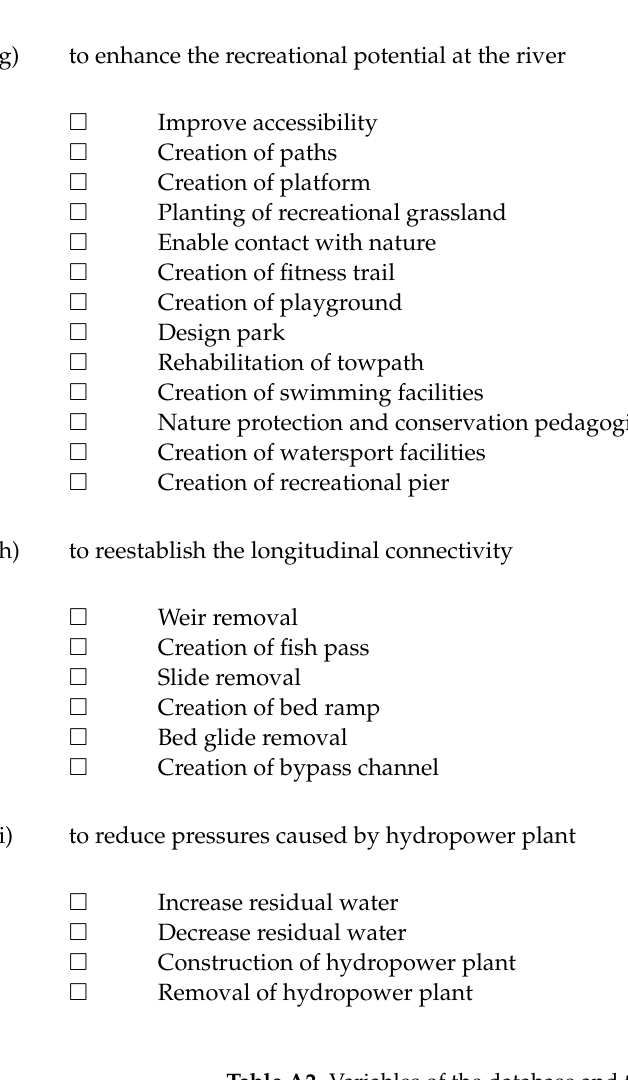
Table A2. Variables of the database and their possible